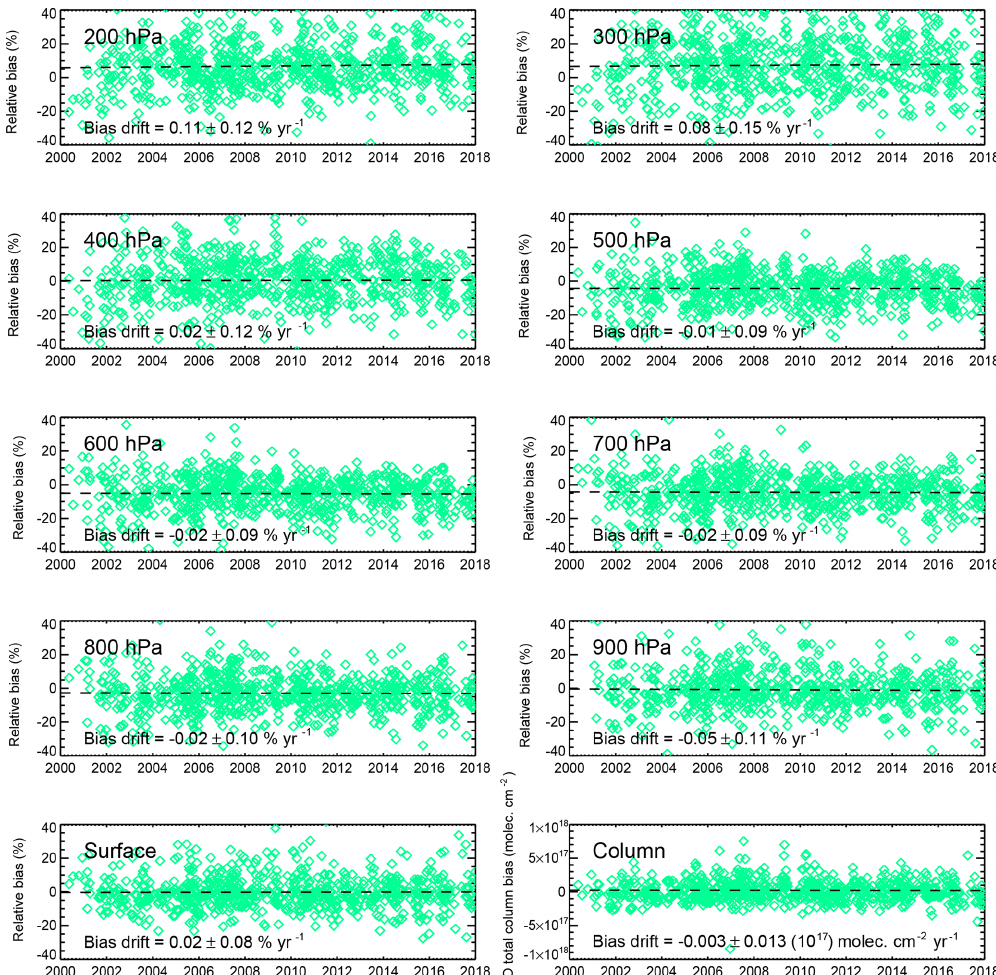
Figure 11. Retrieval bias drift for V8 TIR–NIR products based on the NOAA flask